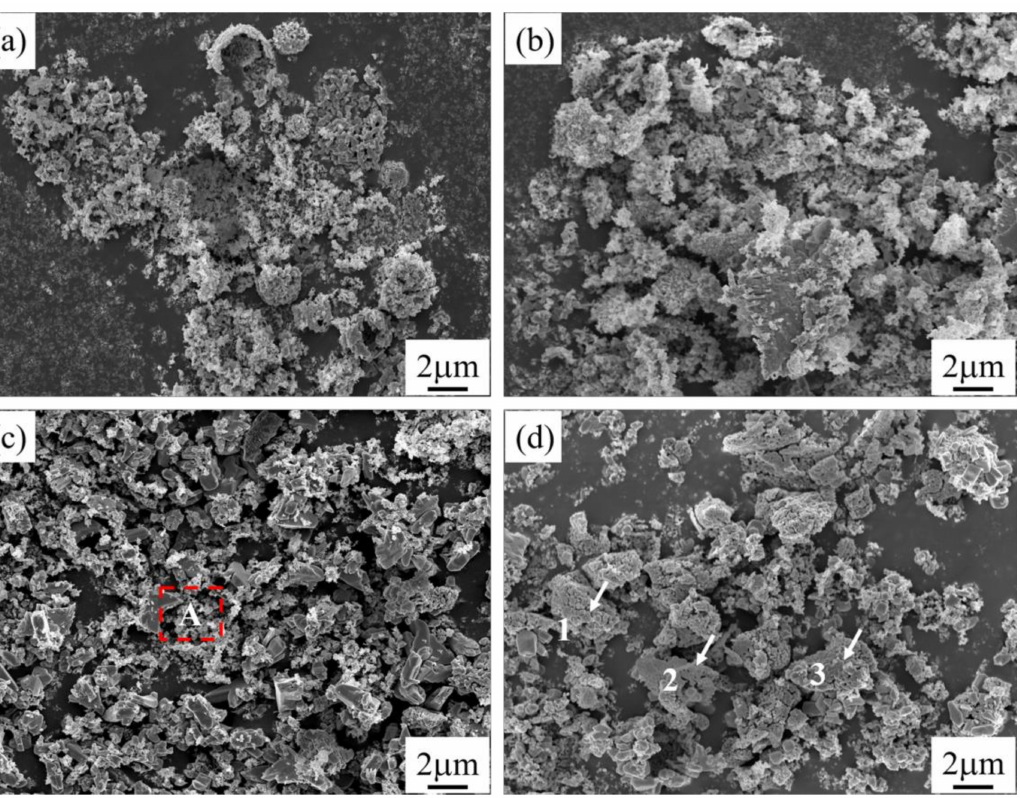
Figure 9. SEM images of Cu-20 wt%W precursor powders calcined at different temperature for 2 h: